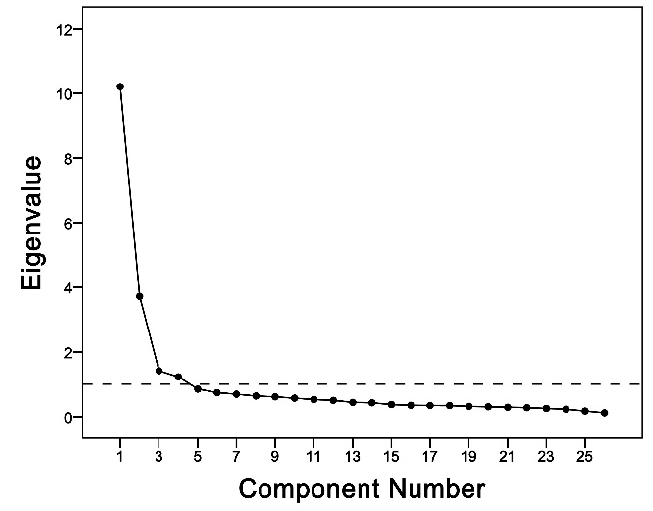
Figure A1. Scree plot of the principal component analysis using the pain scores of 26 painful conditions in dairy cattle scored by 465 dairy practitioners. The dashed line represents the eigenvalue of one.